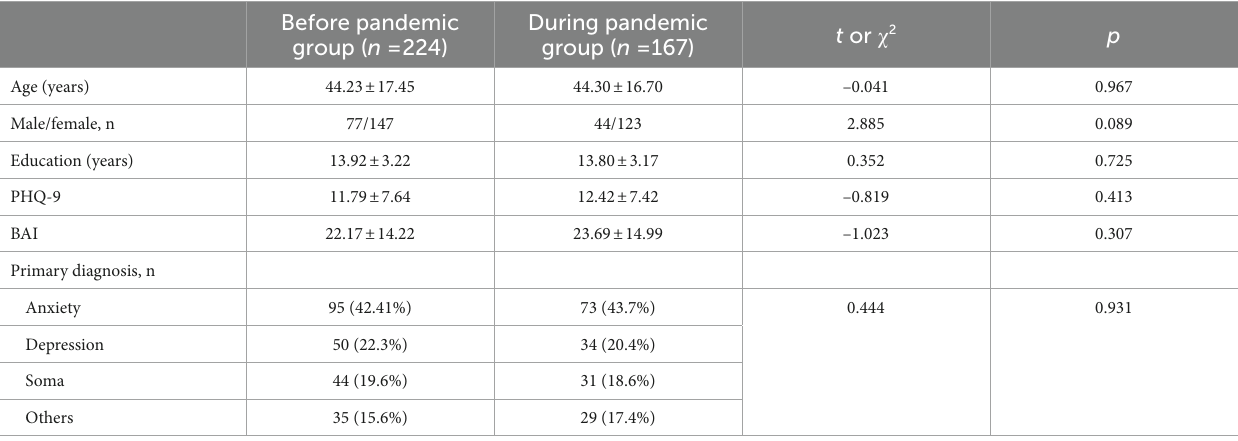
TABLE 1 Clinical characteristics of